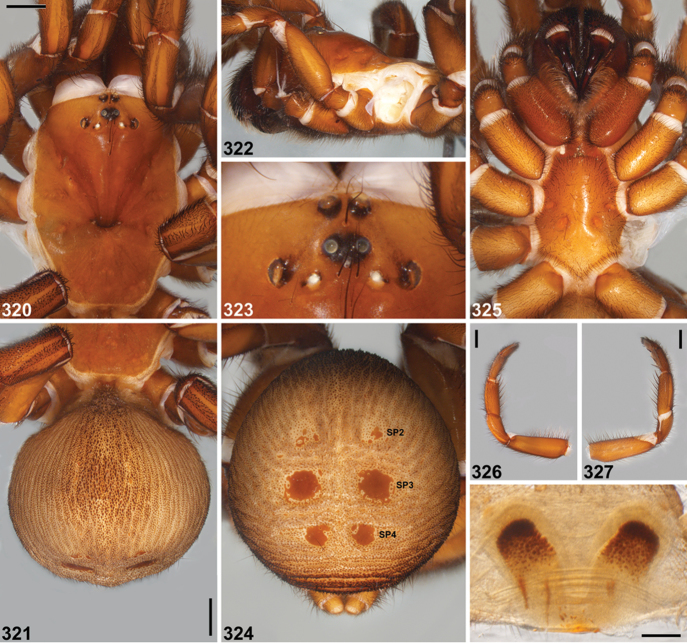

Idiosoma
mcnamarai sp. n., female (WAM T139496) from N. of Cleary (Western Australia; AVW). 320–321 Carapace and abdomen, dorsal view 322 Carapace, lateral view 323 Eyes, dorsal view 324 Abdomen, posterior view 325 Sternum, ventral view 326 Leg I, prolateral view 32 Leg I, retrolateral view 328 Spermathecae, dorsal view. Scale bars 2.0 (320–321, 326–327), 0.5 (328). SP2–4 = sigilla pairs 2–4.